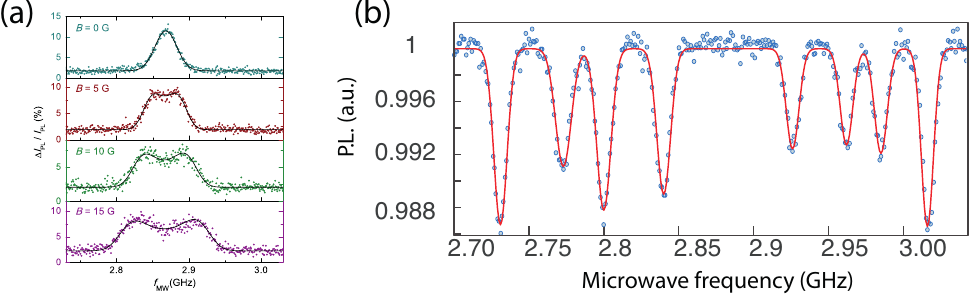
Figure 5. ( a ) ODMR for small ensembles of nano-diamond trapped in water, under increasing magnetic fields. Adapted form [84]. ( b ) ODMR spectrum for a small ensemble of NV − centers in a levitated micro-diamond in a magnetic field of about 50 G. Eight peaks corresponding to the four orientations of the NV − centers, are observed. Reprinted figure with permission from [86]. Copyright 2018 by the American Physical